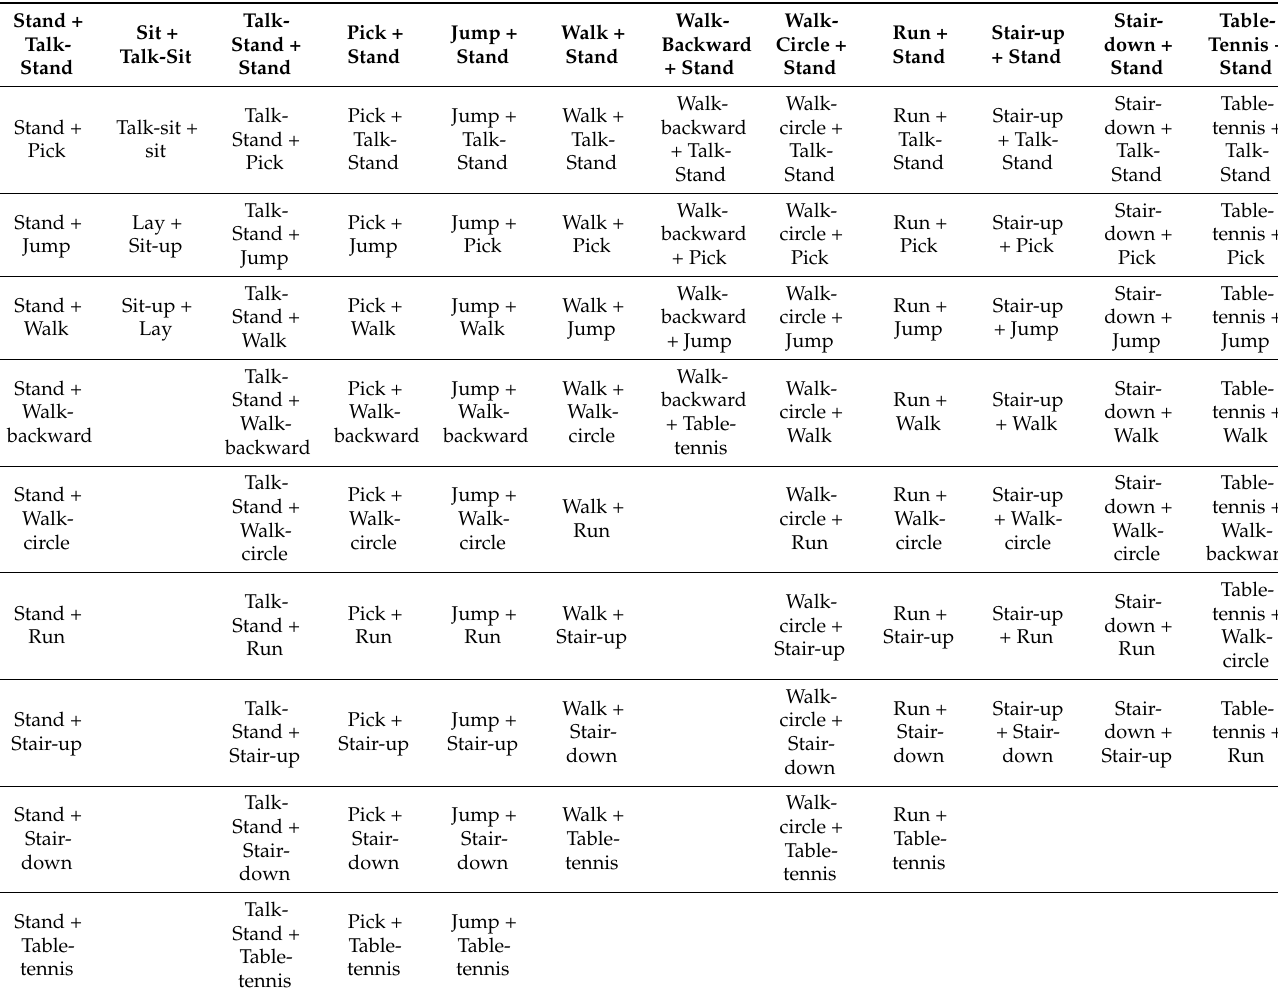
Table 3. Newly created couples of activities.